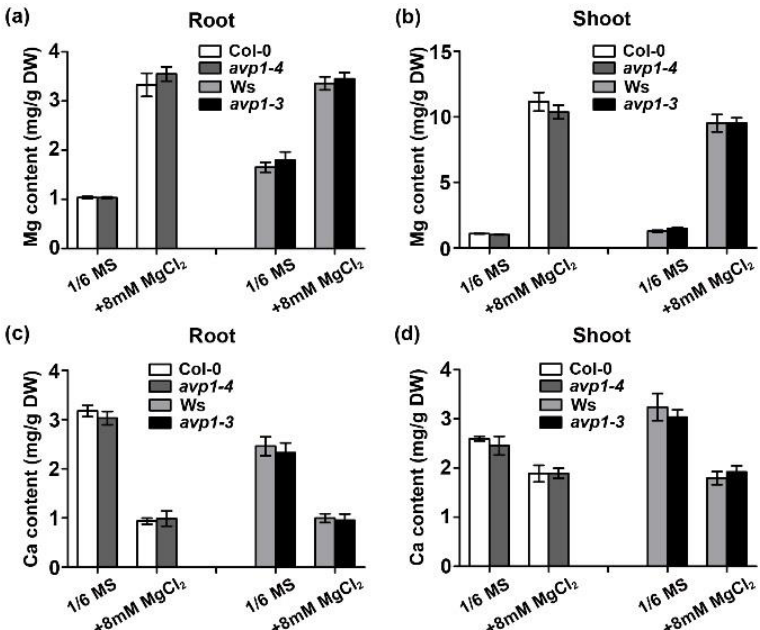
Figure 4. Mg and Ca content in the avp1 mutant under different Mg 2+ conditions. ( a , b ) Mg content in the root (a) and shoot (b) under different Mg 2+ regimes. ( c , d ) Ca content in the root (c) and shoot (d) under different Mg 2+ regimes. Data are presented as the mean ± SD of triplicate experiments.